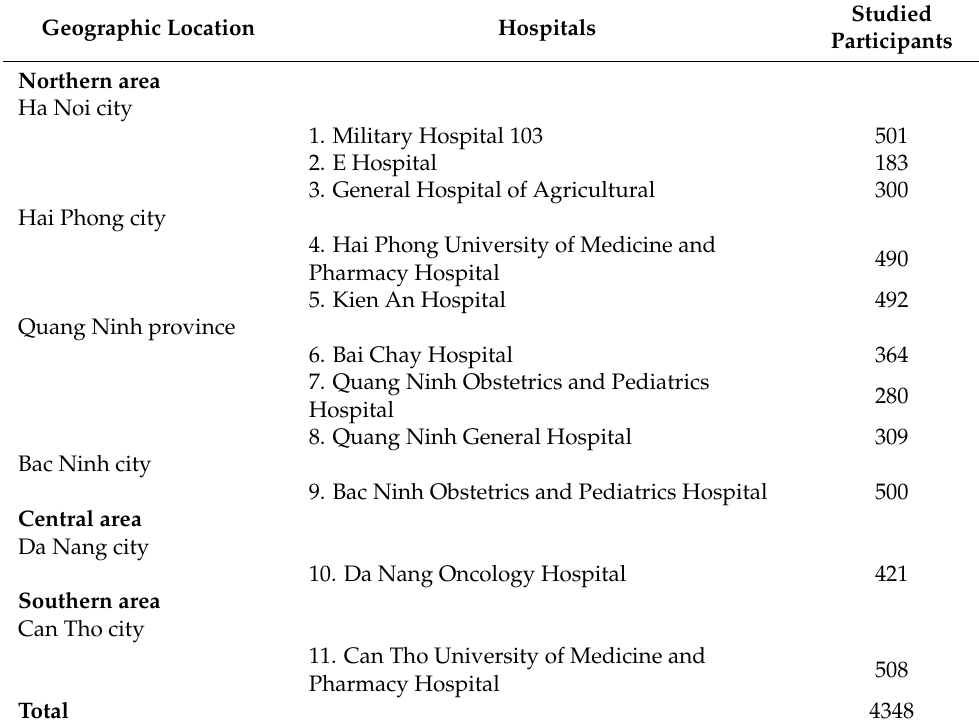
Table 1. Study sample at 11 hospitals across